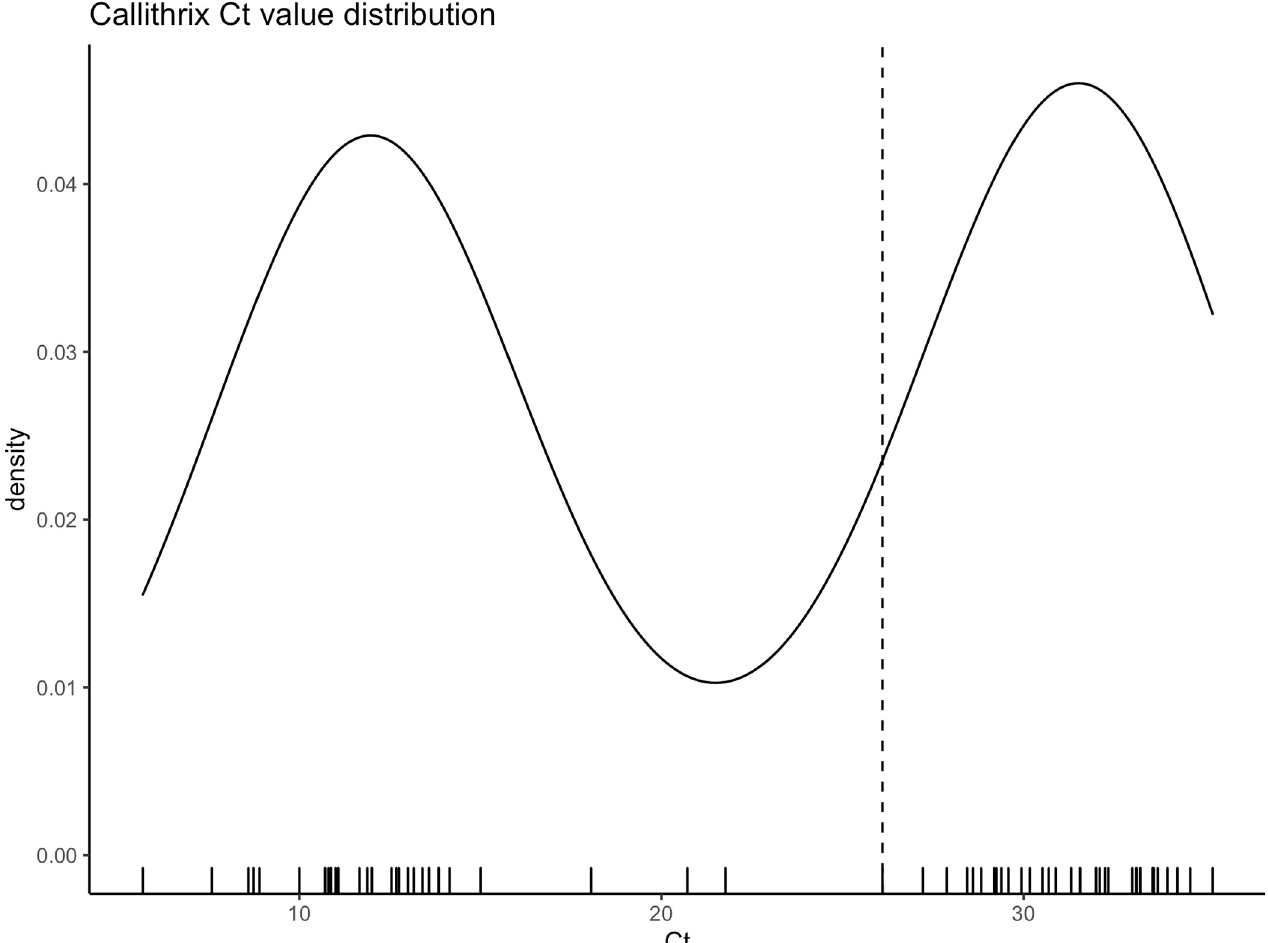
Fig 1. Ct values associated with Callithrix spp. sequences. The median value is shown by a dashed line. Hartigan’s dip test of unimodality indicates bimodal distribution (p <